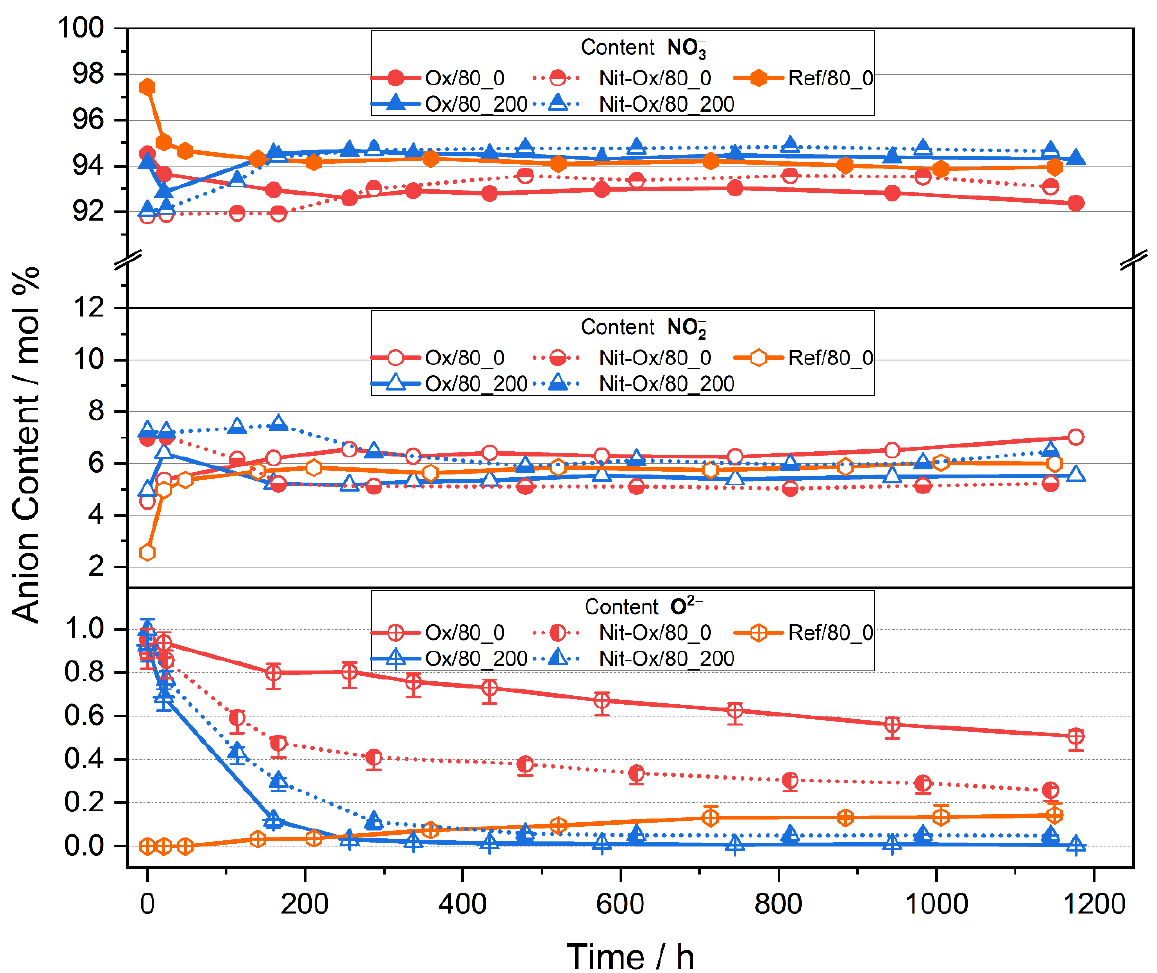
Figure 3. Content of nitrate, nitrite and oxide ions of investigated nitrate melts. Reference data shown (Ref/80_0) did not contain oxide dopant. Salts were stored under 0.8 atm O 2 with/without 200 ppm NO and with/without added nitrite indicated by the label. Error bars not visible are within symbol size.